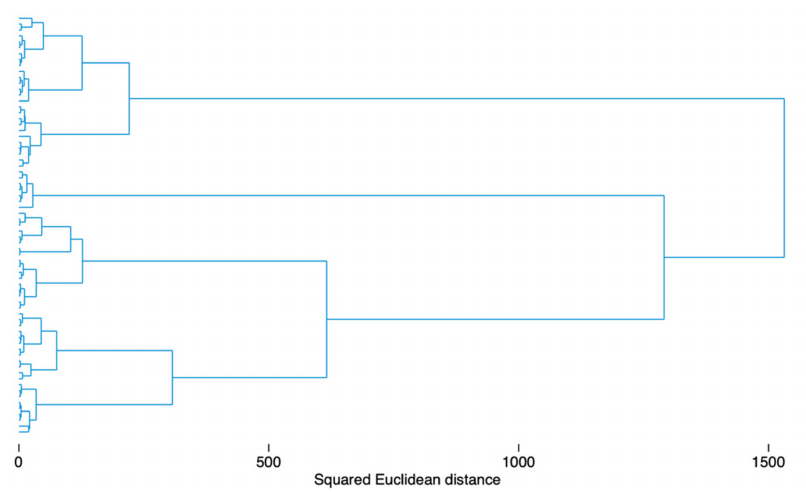
Figure 2. Dendrogram for the hierarchical cluster analysis.